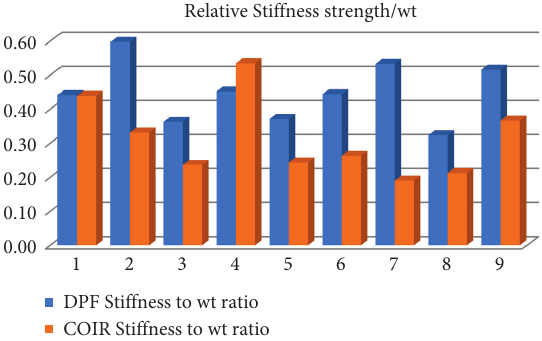
Figure 12: Relative stiffness strength/weight ratios of composites.